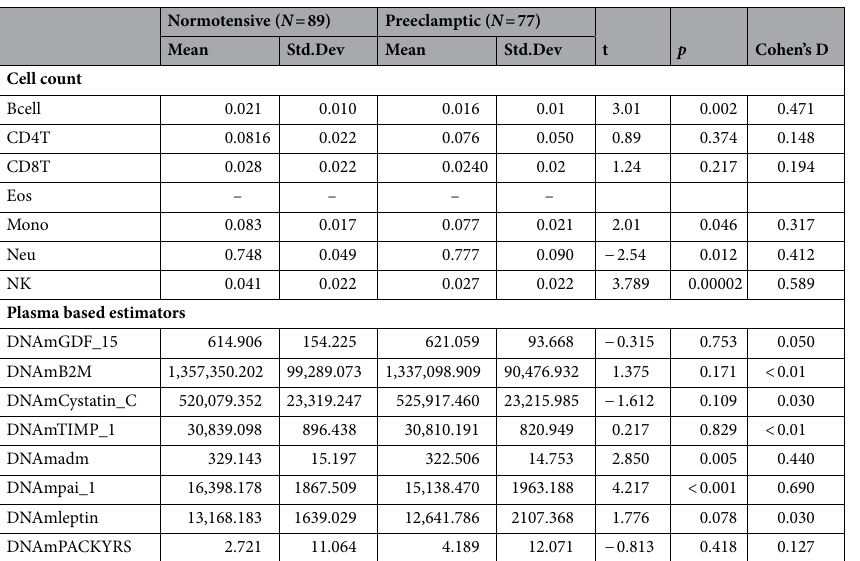
Table 4. Independent t-tests between average DNAm-based cell count and estimators of plasma proteins among normotensive and preeclamptic women. Growth differentiation factor 15 (GDF15), cbeta-2- microglobulin (B2M), cystatin C, ltissue inhibitor metalloproteinases 1 (TIMP1), adrenomedullin (ADM), plasminogen activation inhibitor 1